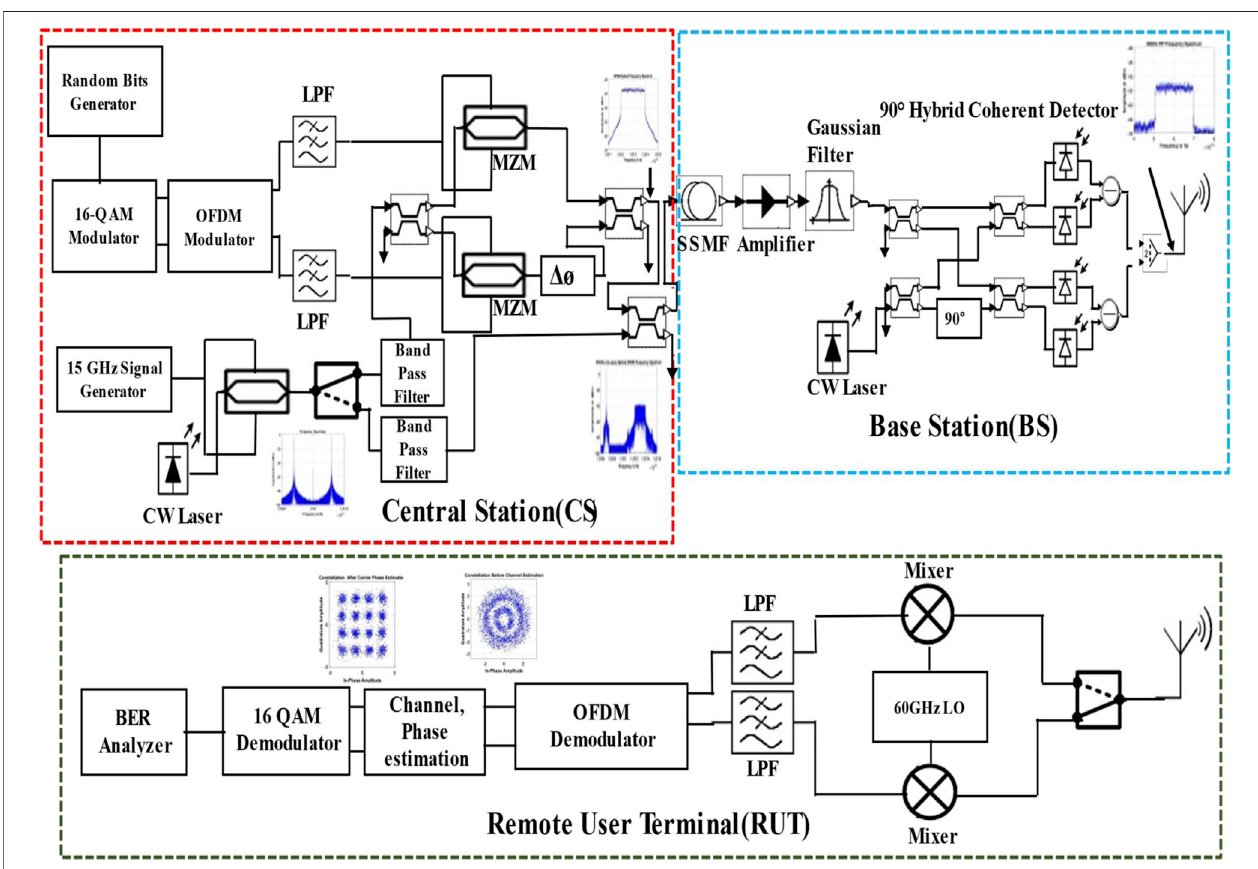
FIGURE 2 | Proposed setup of 60 GHz RoF